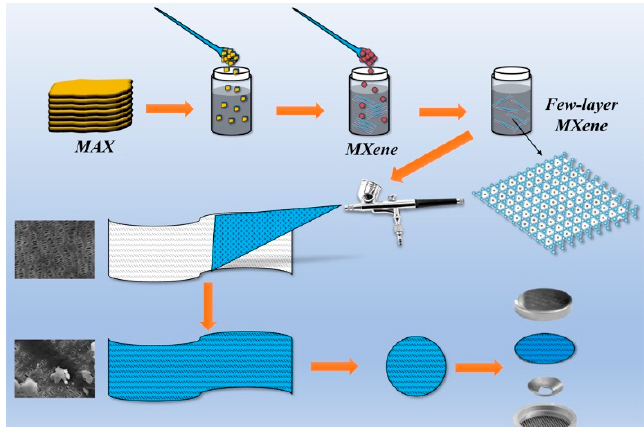
Figure 1. Schematic diagram of assembling MXene/PP diaphragm.